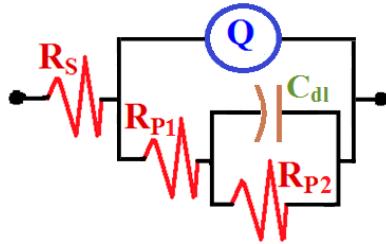
Figure 4. The equivalent-circuit model that fits the collected impedance data. Table 2. Summary for the polarization data for the Ti alloys in 3.5% NaCl